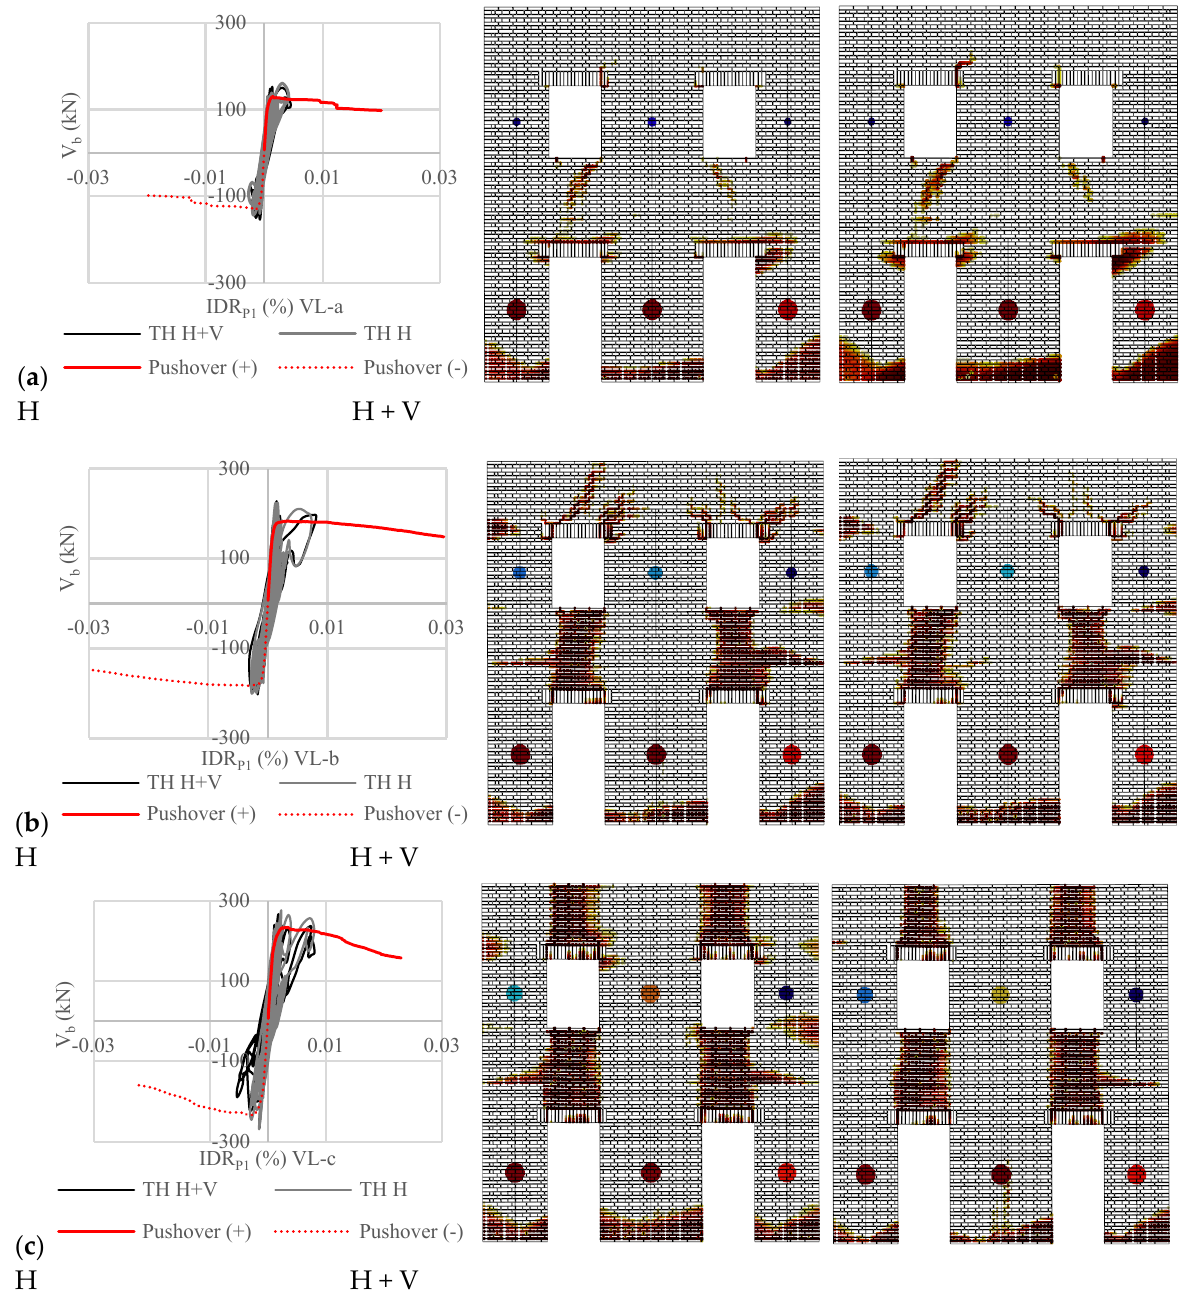
Figure 17. IDR- V b curves and crack patterns obtained for the earthquake #1. TH results for the H component are in grey, TH results for H + V components are in black, the PO curve for positive displacements is the continuous red line, and the PO curve for negative displacements is the dashed red line. Loading conditions: VL-a ( a ), VL-b ( b ), and VL-c ( c ).